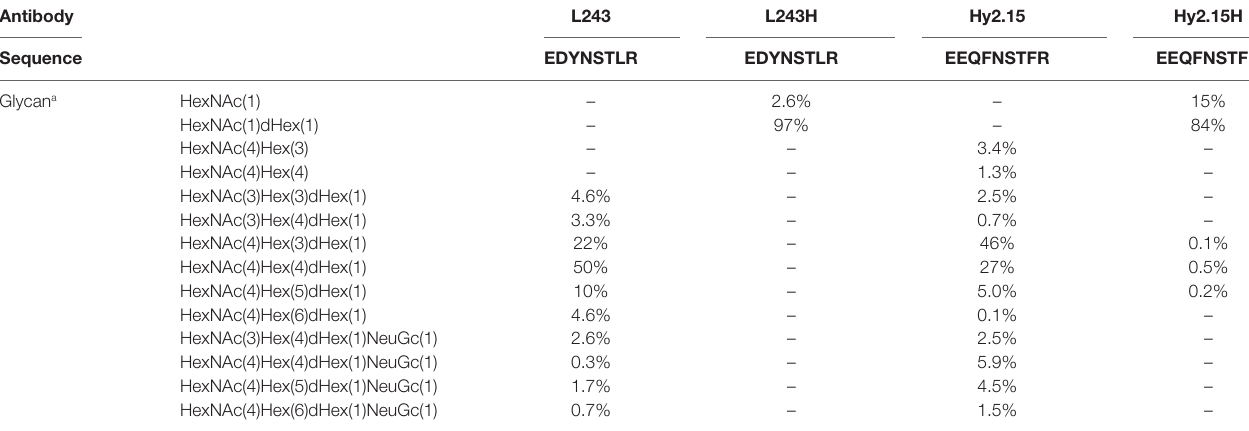
TaBle 2 | Joint unrelated antigen(s)-specific IgG glycoforms before and after endo- β - N -acetylglucosaminidase (EndoS) hydrolyzation.